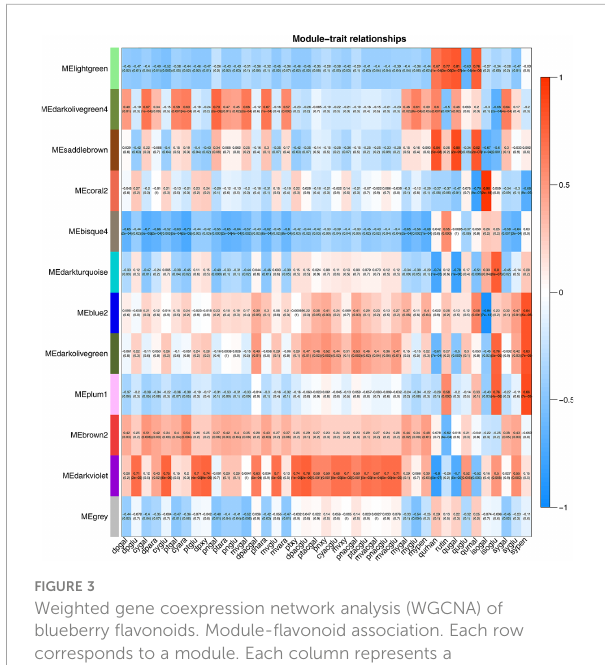
FIGURE 3 Weighted gene coexpression network analysis (WGCNA) of blueberry fl avonoids. Module- fl avonoid association. Each row corresponds to a module. Each column represents a speci fi c fl